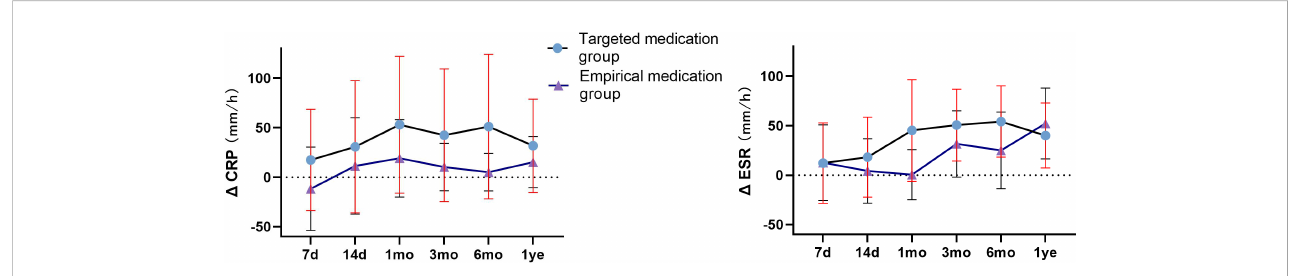
FIGURE 6 The comparison of the difference of D CRP (pre-op CRP-post-op CRP) and D ESR (pre-op ESR-post-op ESR) between two groups at different follow-up times. CRP, C-reactive protein; ESR, erythrocyte sedimentation rate.